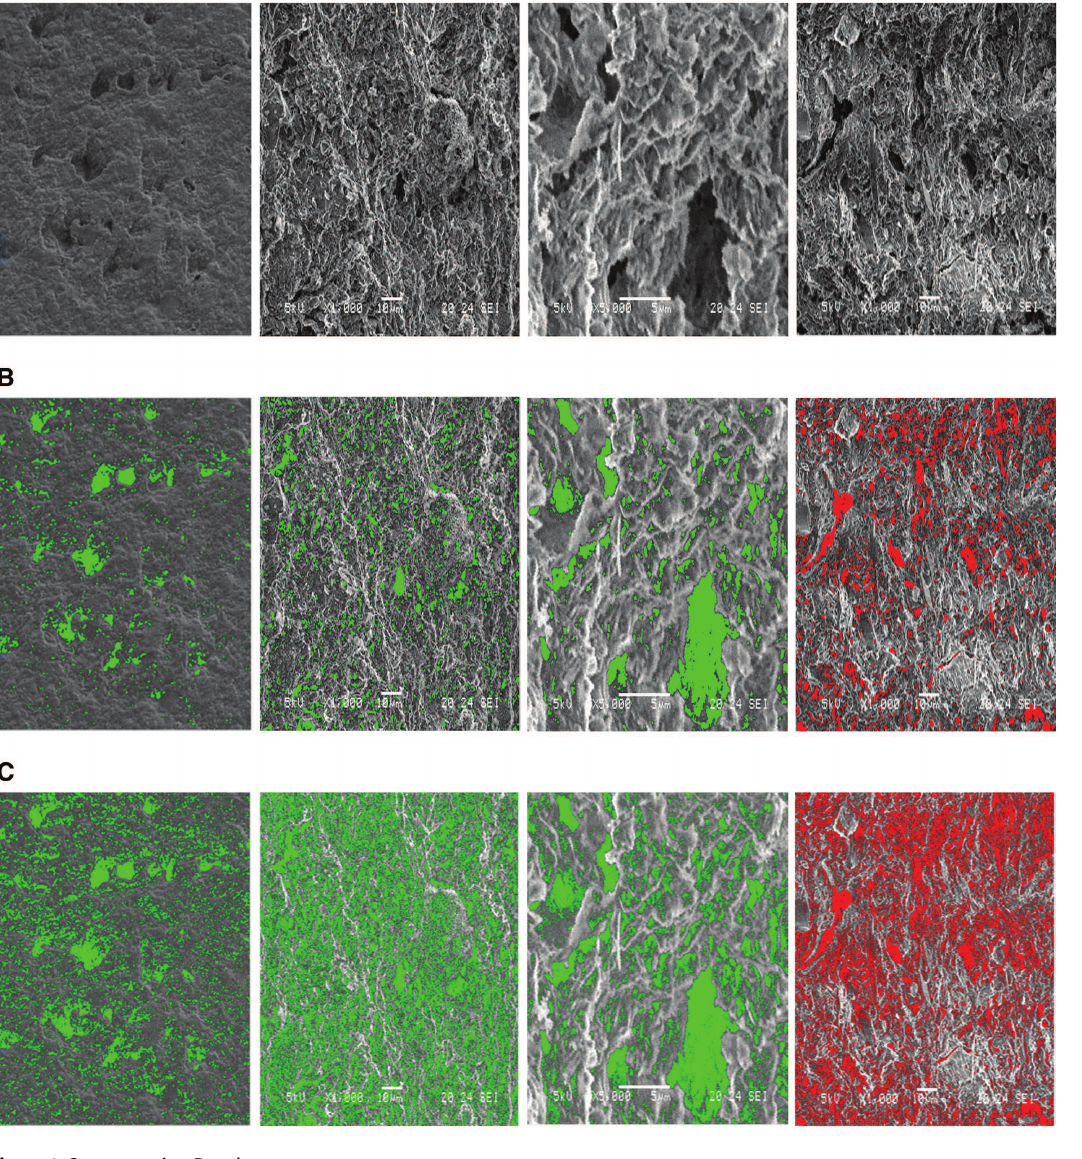
Figure 1: Segmentation Results. (A) Original images; (B) corresponding VD segmentation; (C) corresponding threshold segmentation; (D) corresponding clustering segmentation; and (E) corresponding watershed